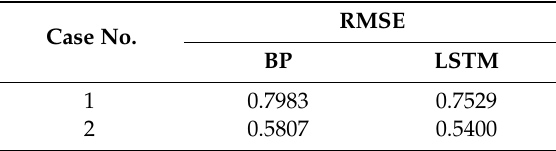
Table 2. Performance comparison of BP and